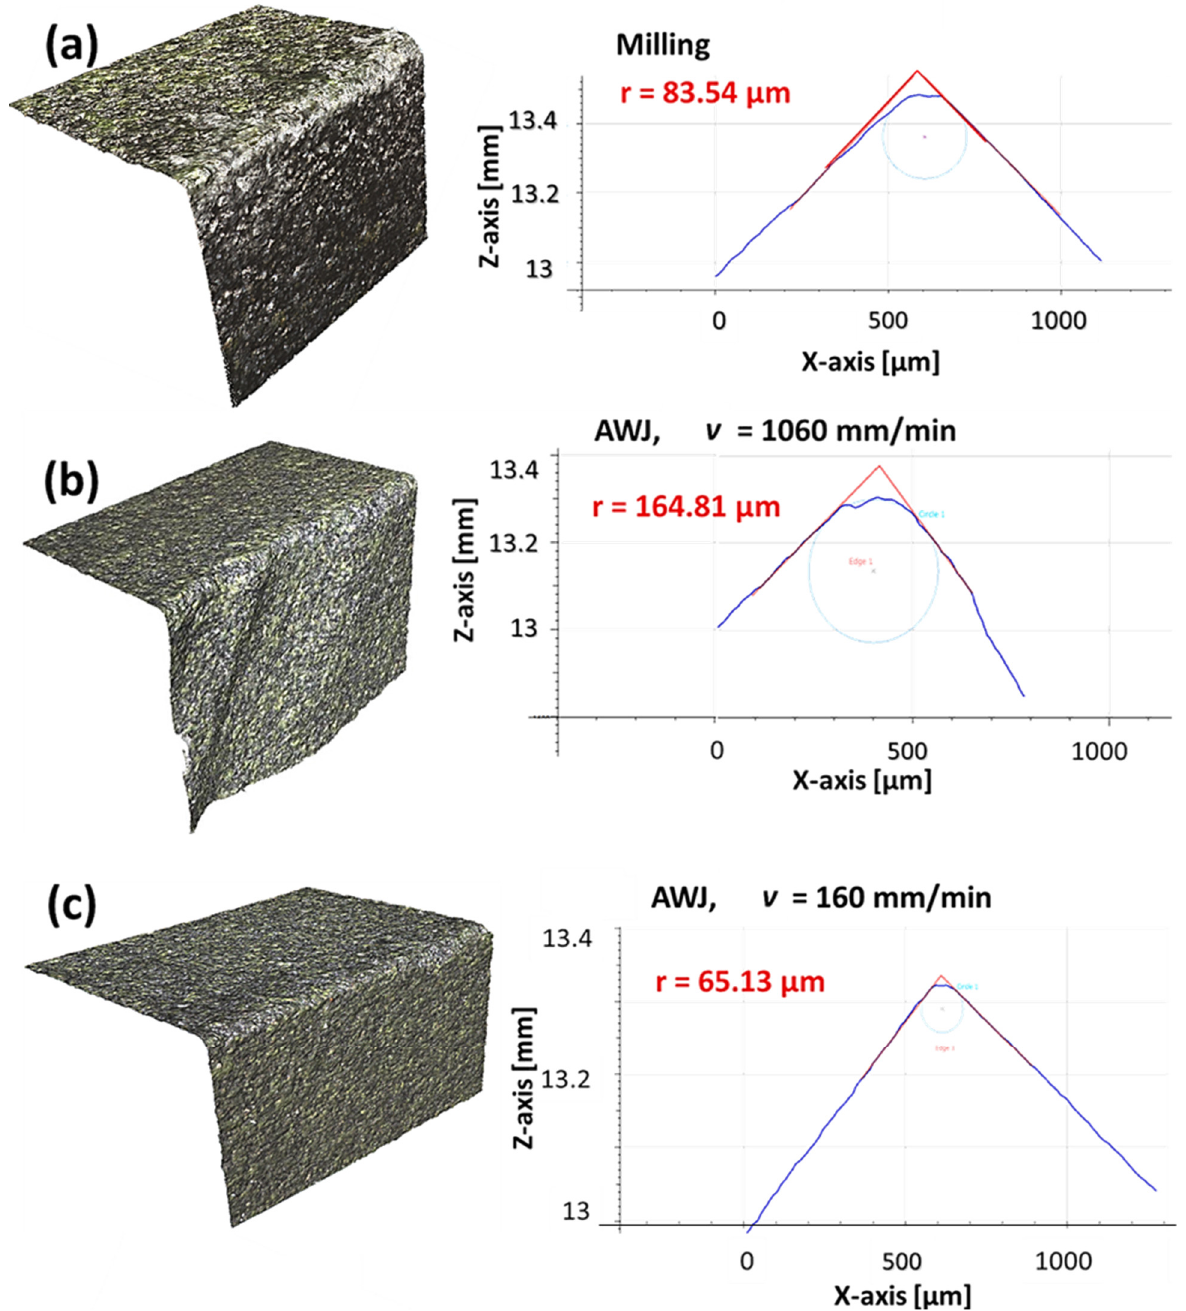
Figure 8. The edge profile comparison between the ( a ) optimally milled and ( b ) the coarsest edge with feed rate 1060 m/min, and ( c ) the best AWJ cut ceramic at the feed v = 160 mm/min.